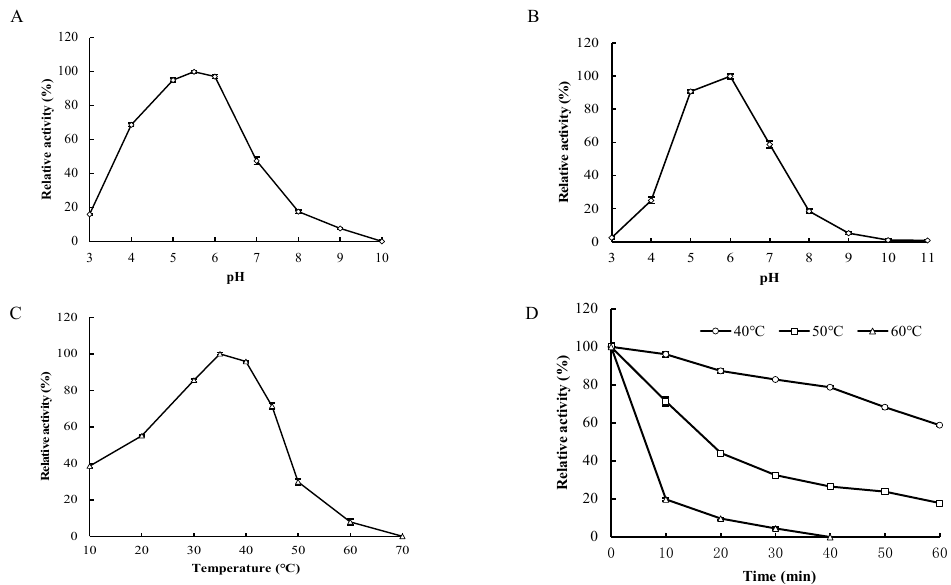
Figure 2. Enzymatic properties of purified rHynACF8. ( A ) pH-dependent activity. ( B ) pH-dependent stability. ( C ) Temperature-dependent activity. ( D ) Temperature-dependent stability. Error bars represent the means ± SD ( n = 3).